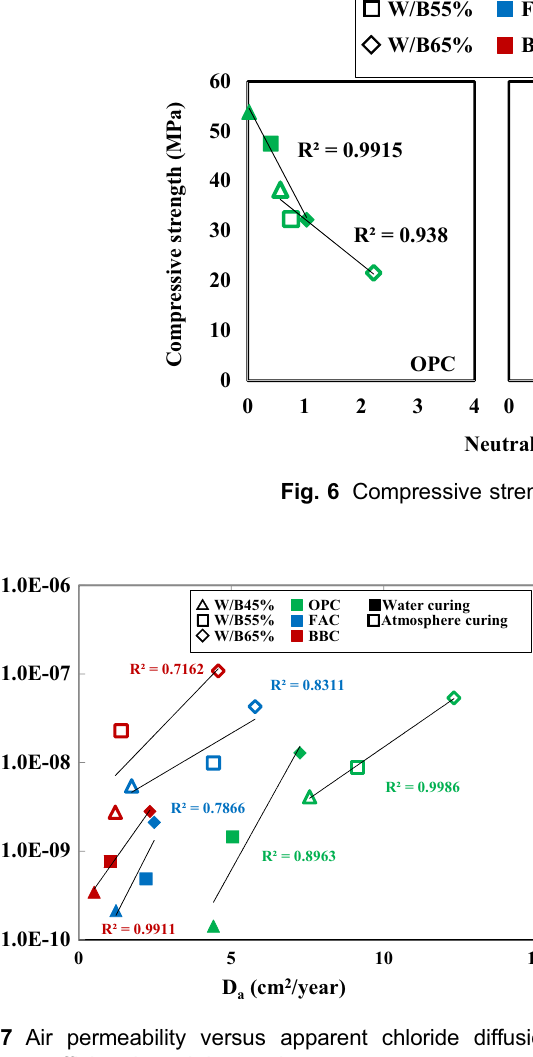
Fig. 7 Air permeability versus apparent chloride diffusion coefficient by salt immersion test.